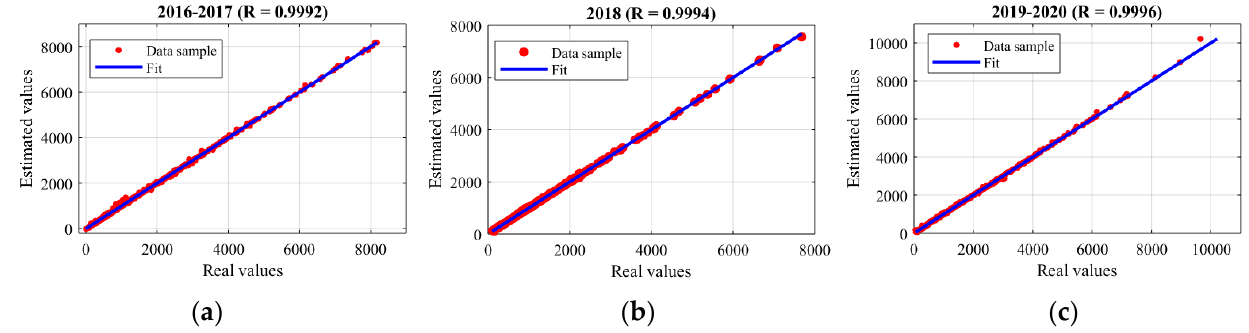
Figure 8. Predicted energy consumption for the low-consumption profile in regression format: ( a )